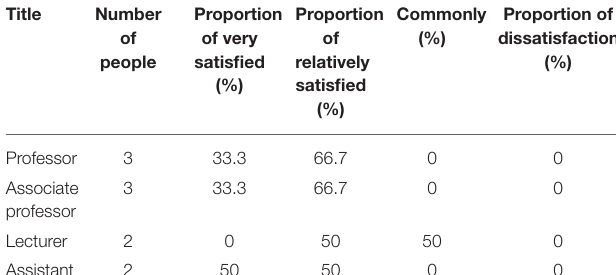
TABLE 2 | University teachers’ evaluation of the content and data of the questionnaire.